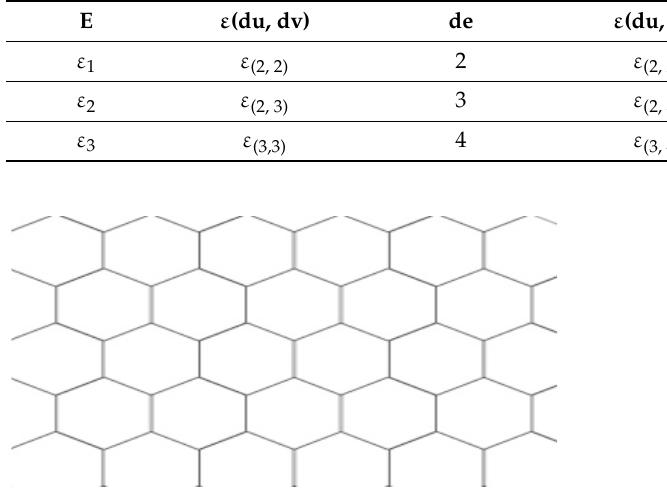
Figure 9. Regular hexagonal cells network.